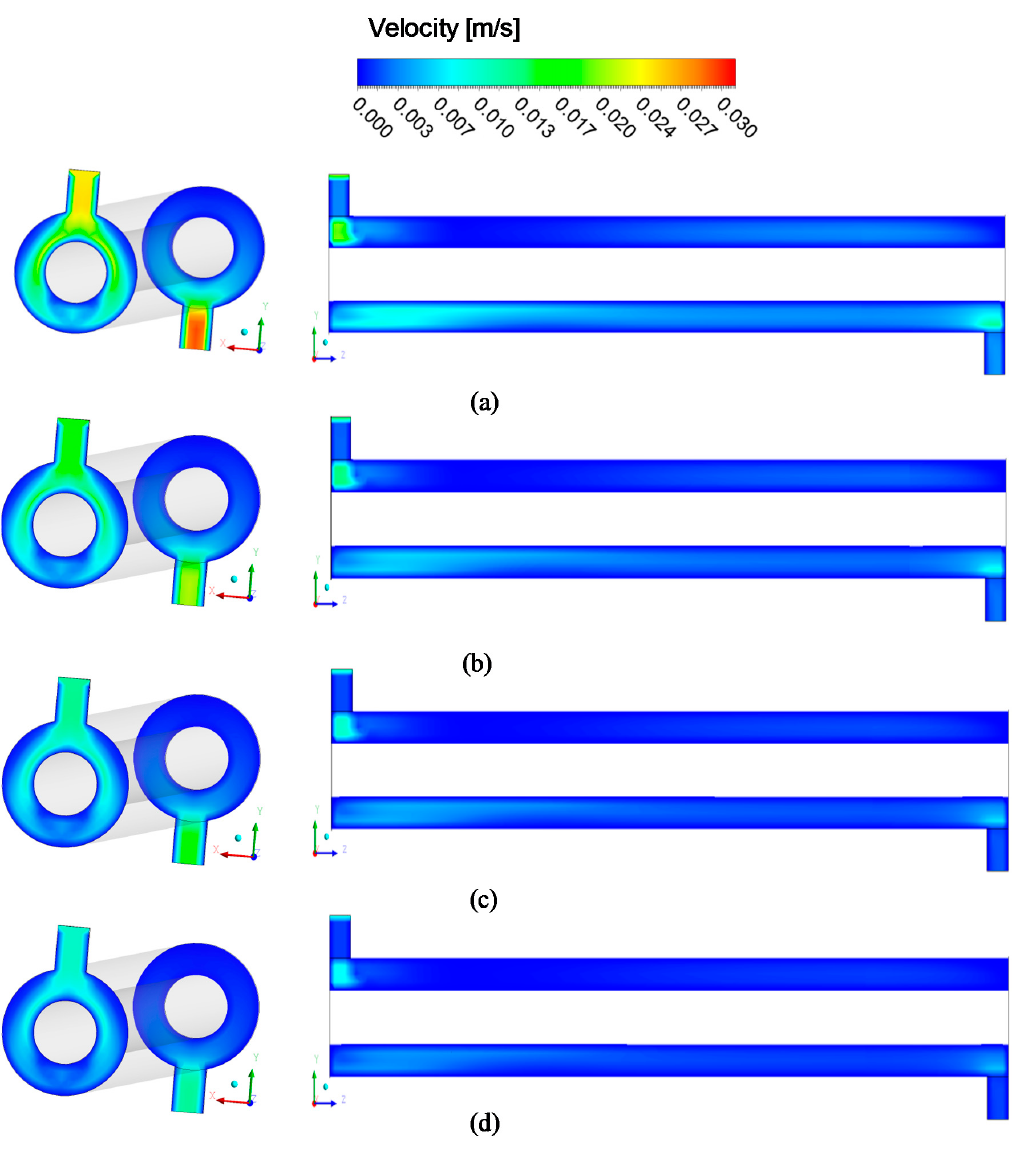
Figure 8. Velocity field for temperatures of ( a ) 35 °C, ( b ) 55 °C, ( c ) 75 °C and ( d ) 95 °C (Cases 5–8).